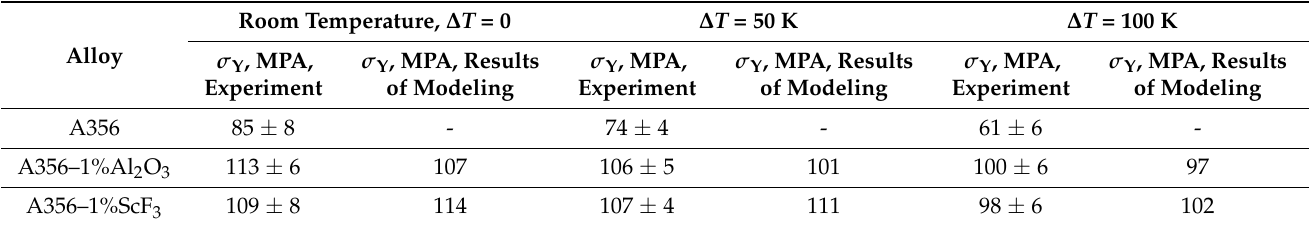
Table 4. Yield strength of A356 alloy and A356-based